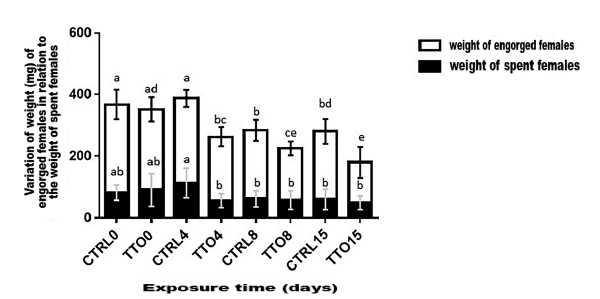
Figure 3. Variation of weight (mg) of engorged females (white bars) in relation to the weight of spent females (black bars) in function of exposure time to the product: CTRL (control); TTO (exposed to fluazuron). Mean ± standard deviation. Equal letters do not differ significantly between each other ( p >0.05) by the Tukey